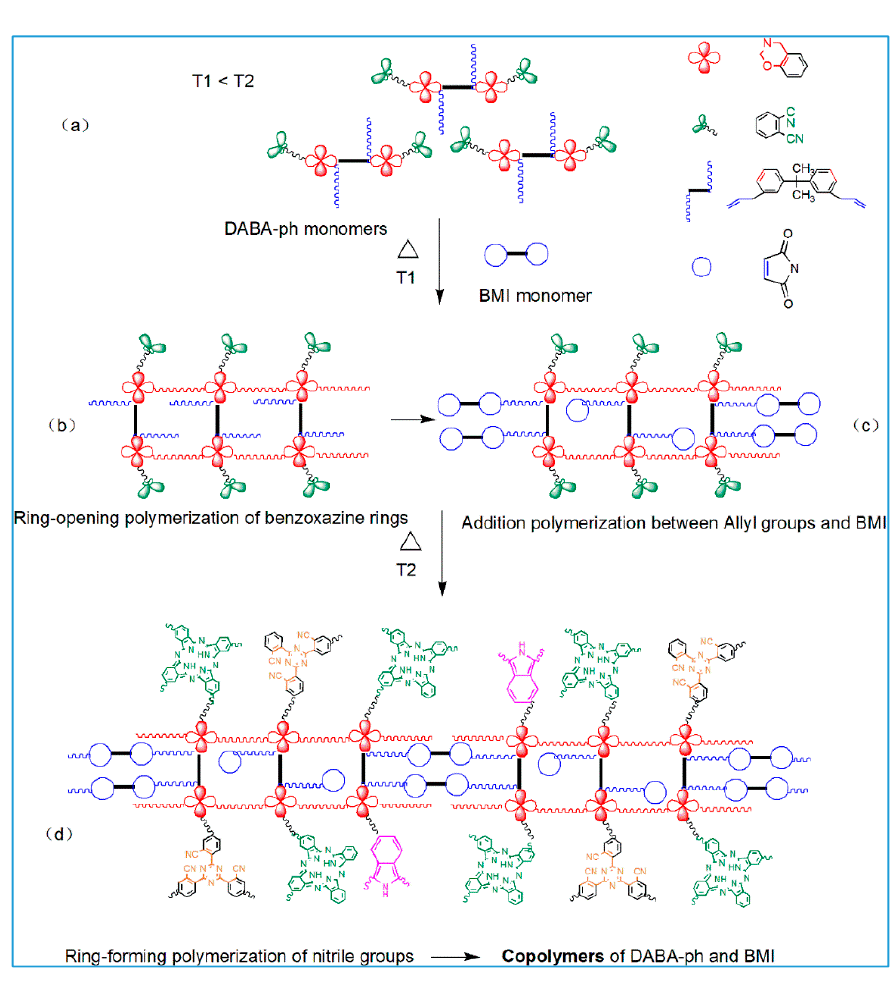
Figure 4. FTIR spectra of ( a ) DABA-Ph monomer; ( b ) BMI monomer; ( c ) DABA-Ph/BMI-2/1 prepolymer; ( d ) DABA-Ph/BMI-1/1 prepolymer and ( e ) DABA-Ph/BMI-1/2 prepolymer treated at 200 °C.